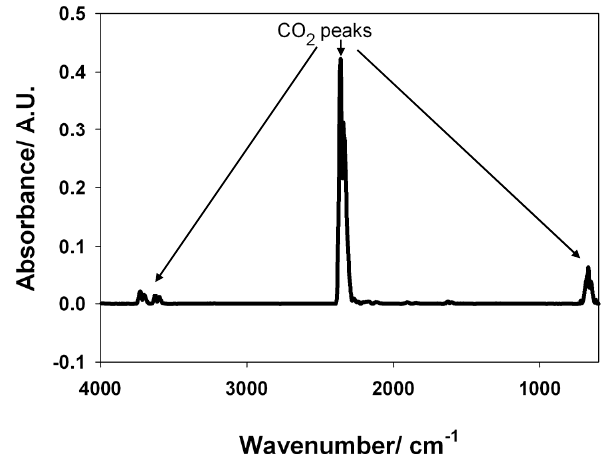
Fig. 2. Single scan of online evolved gas as measured by the FTIR- EGA system, with corresponding CO 2 peaks.